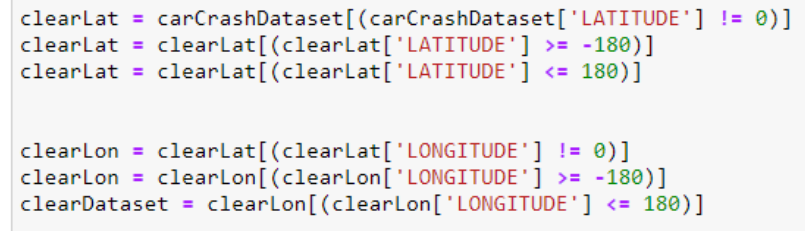
Figure 4. Adding the libraries required for operation.